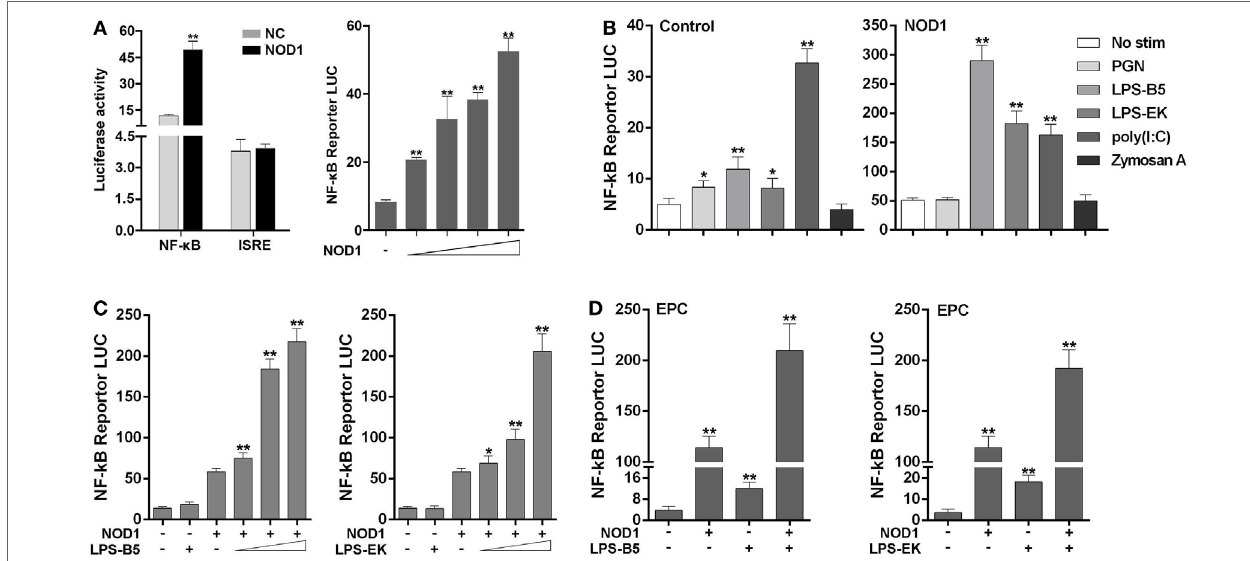
FigUre 4 | NOD1 is sensitive to lipopolysaccharide (LPS) and activate NF- κ B signal pathway. (a) Co-transfection of miiuy croaker NOD1 expression plasmid along with NF- κ B or ISRE reporter plasmid into HEK293 cells, respectively, and at 48 h after transfection, the cells were collected to detect the luciferase activity, and then transfected with different amount of NOD1 plasmids into HEK293 cells to perform a concentration gradient experiment. (B) HEK293 cells were transfected with NOD1 expression plasmid or empty plasmid along with NF- κ B reporter plasmid, and then, cells were stimulated with PGN, LPS-B5, LPS-EK, poly(I:C), and Zymoscan A, after 12 h of stimulation, cells were collected to detect the luciferase activity. (c) The concentration gradient experiment of LPS-B5 and LPS-EK. (D) EPC cells were transfected with NOD1 expression plasmid or empty plasmid along with NF- κ B reporter plasmid, then cells were stimulated with LPS, after 12 h of stimulation, the cells were collected to detect the luciferase activity. All the experiments were co-transfected with Renilla luciferase reporter (pRL-TK, Promega) plasmid as the internal control, the data were represented as mean ± SE. The statistically significant differences between control and experience groups were shown with asterisks (* P < 0.05 and ** P <